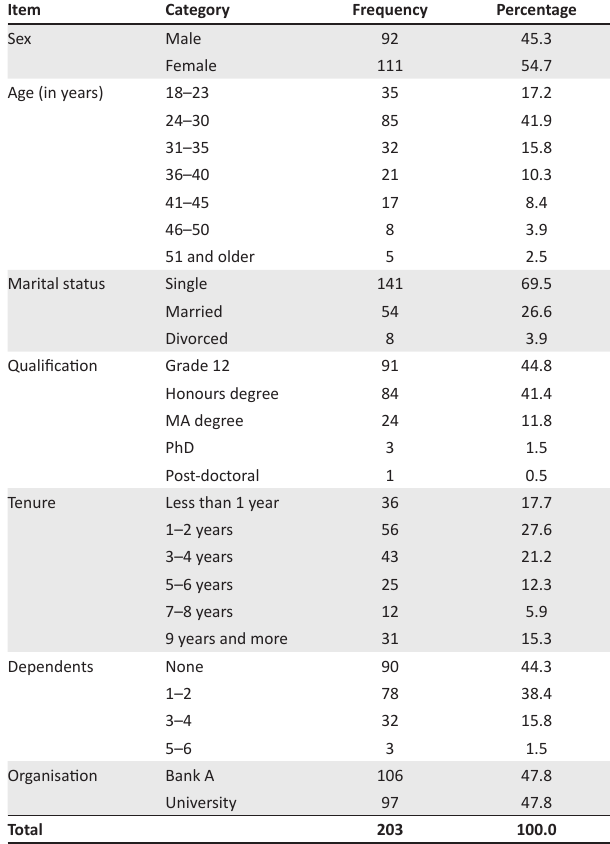
TABLE 1: Biographical details of sample ( n =